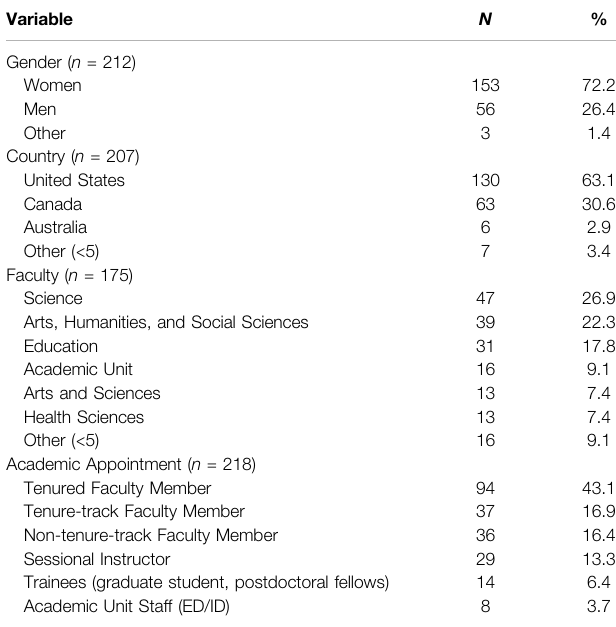
TABLE 1 | Demographics and professional experience of participants.